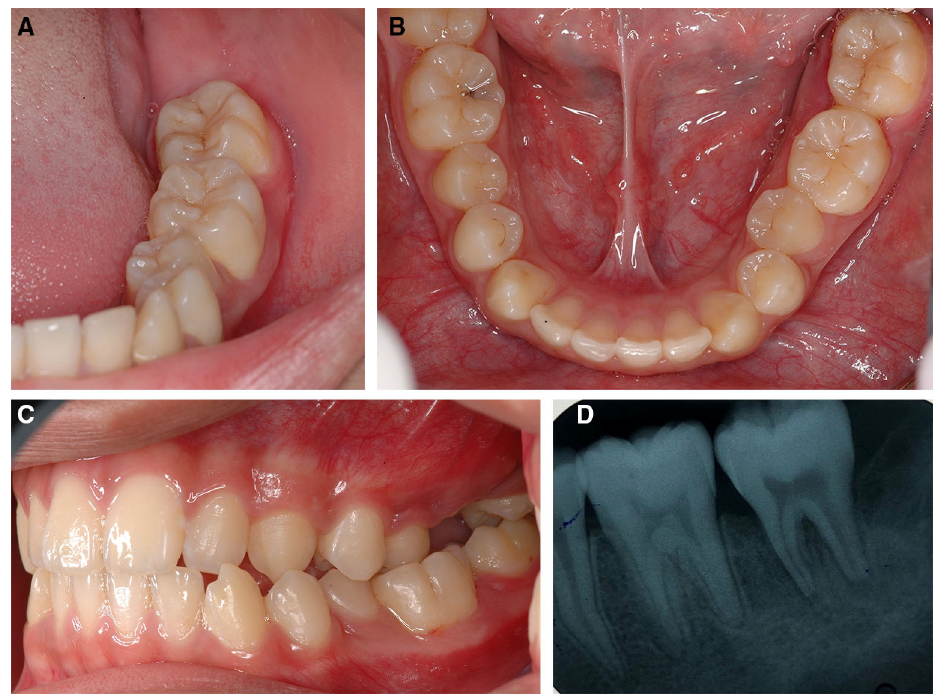
Figure 8. The clinical outcomes after LANAP procedure. A, B and C. Intraoral features after LANAP showing the normal appearance of the gingivae of the lower left molars and the repositioning of the teeth to their previous location and occlusion. D. Periapical radiograph of tooth no. 36 and tooth no. 37 showing an increase in periapical radiopaque characteristics in the previous